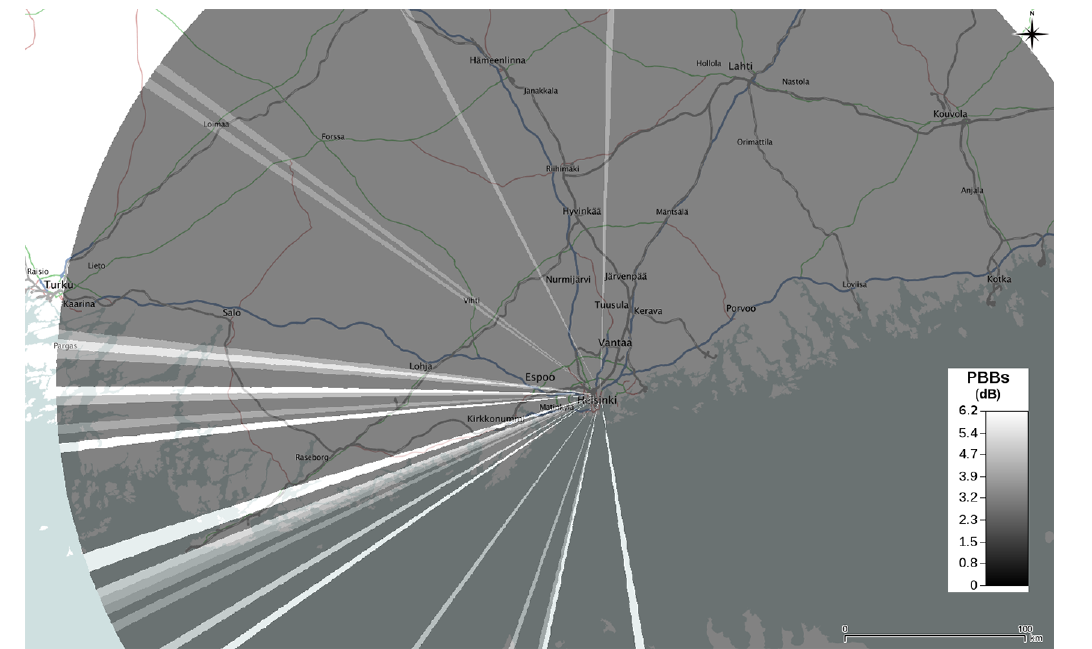
Figure 4. Estimated partial beam blockages for Kumpula